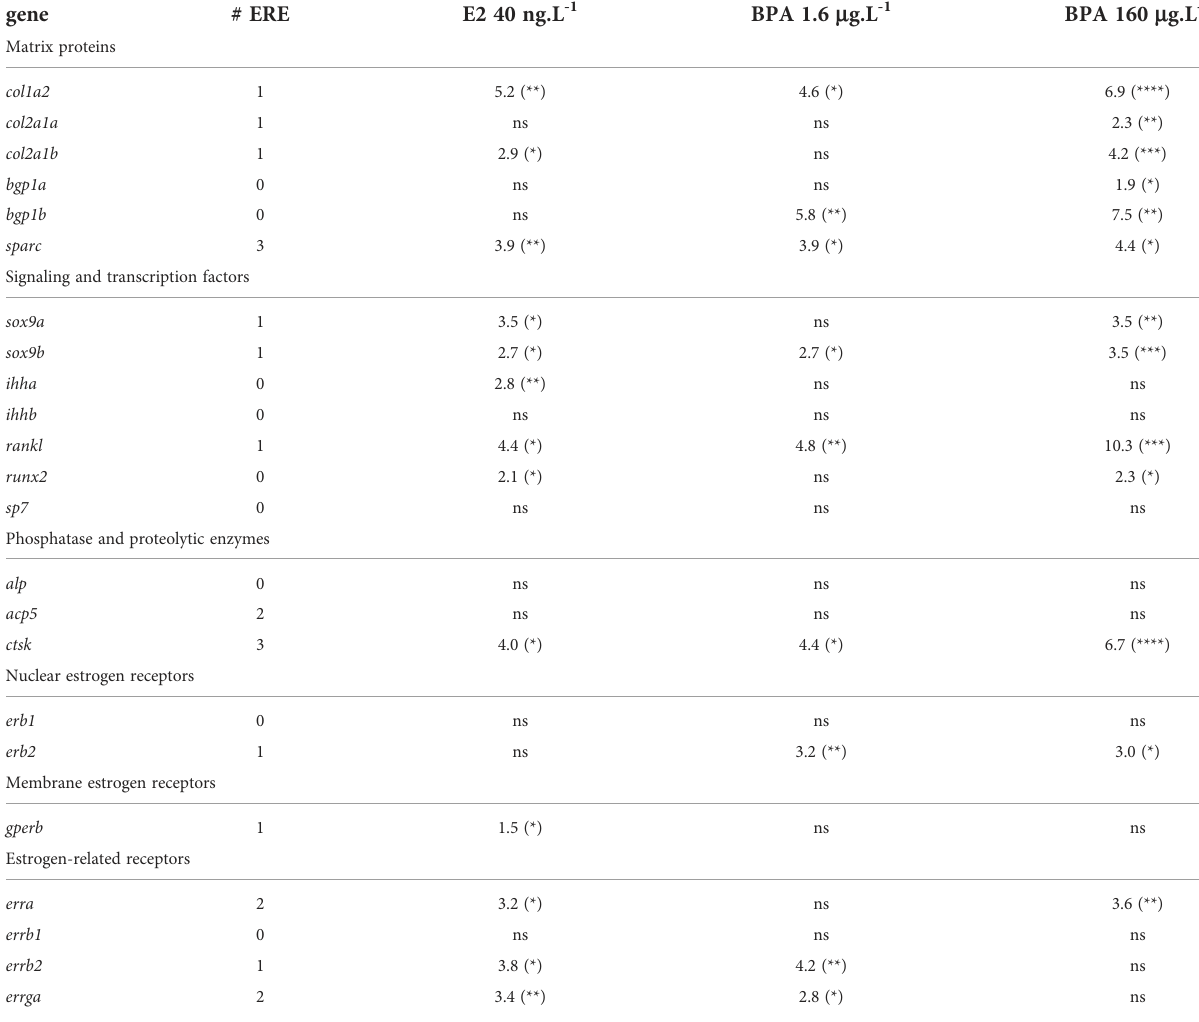
TABLE 3 ERE consensus motif detection and summary of the signi fi cant effects of E2 and BPA treatments on the expression of the selected genes.